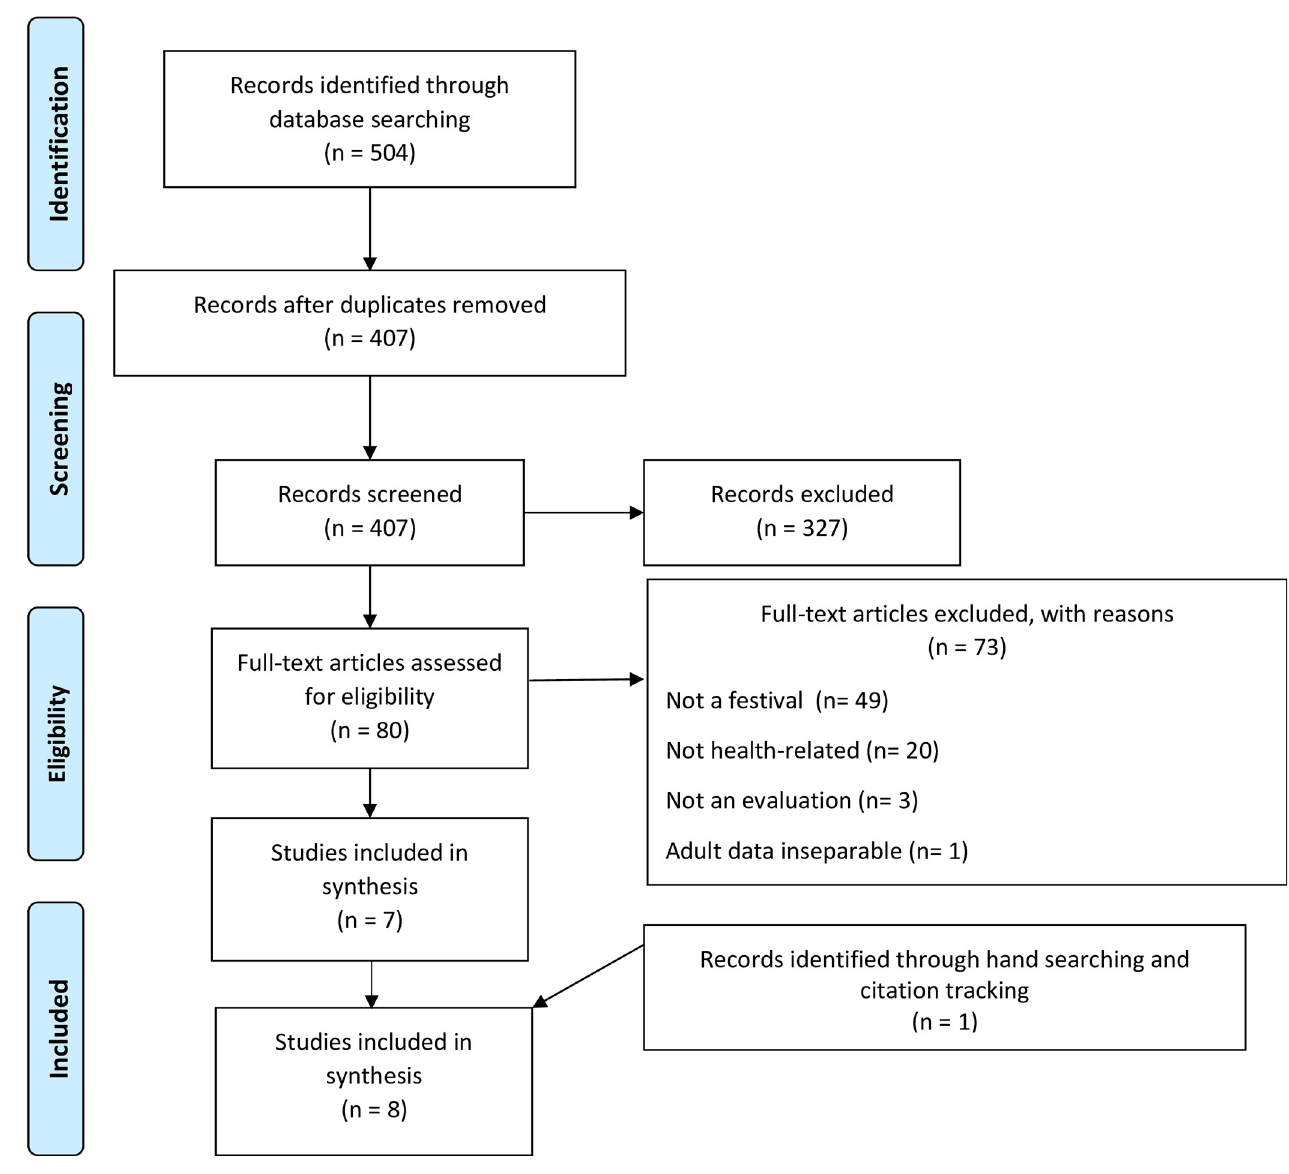
Fig 1. PRISMA flow